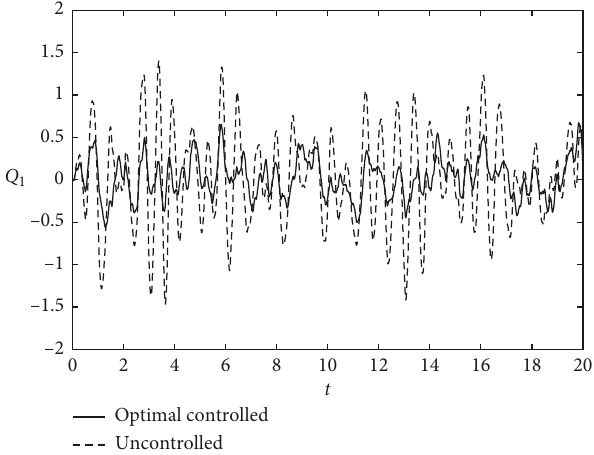
Figure 6: The sample time history of displacement Q trolled system compared with uncontrolled